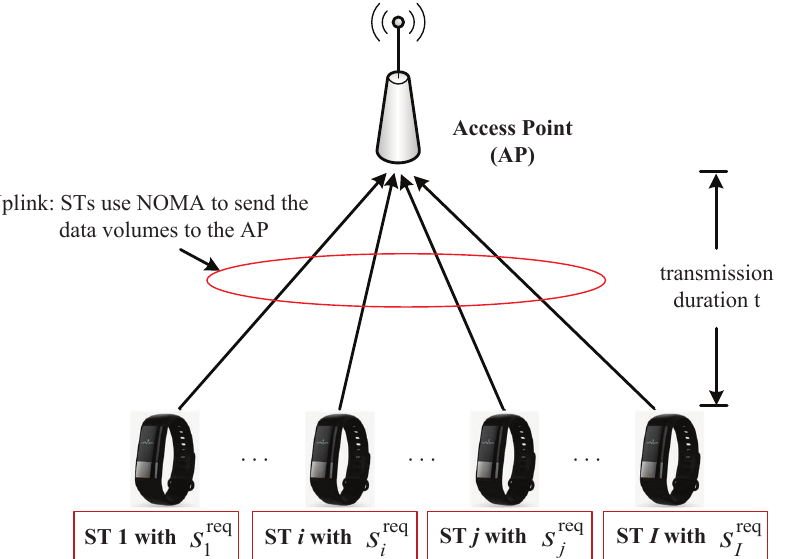
Figure 1. Illustration of the system model. A group of I STs use NOMA to send data to the AP simultaneously. Each ST i has a data volume of s req to be delivered. The transmission duration of the i STs’ simultaneous NOMA transmissions is denoted by t .